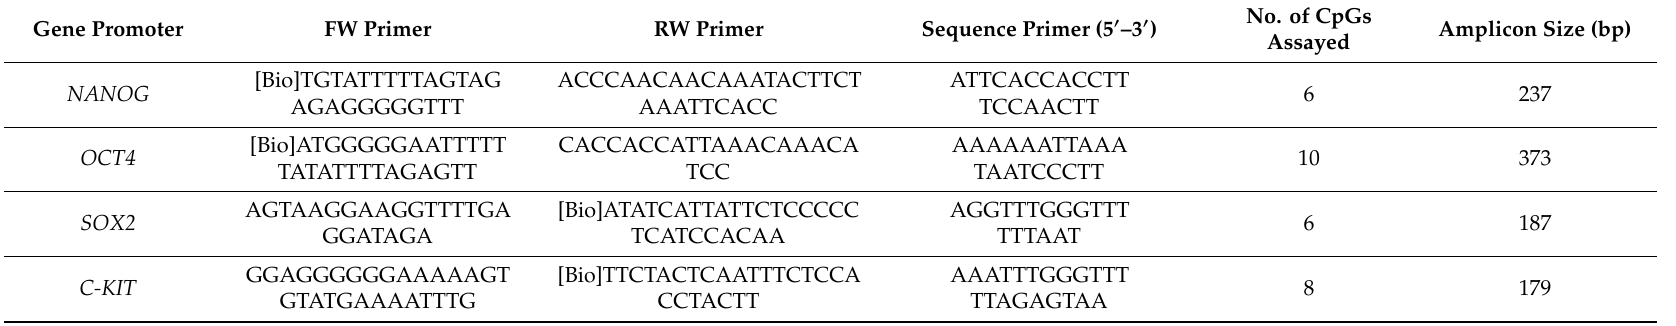
Table 4. Primer for